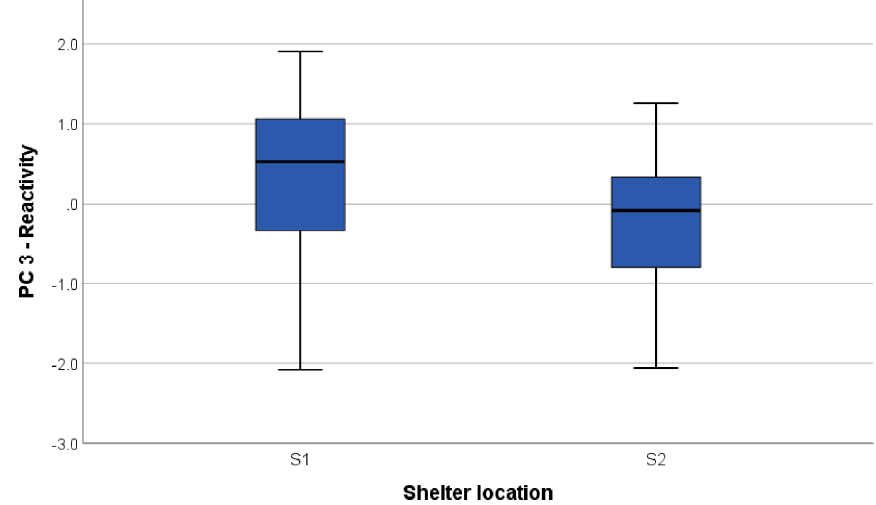
Figure 4. Boxplot showing the difference in the ‘reactivity’ scores (component 3 of the PCA) between the dogs housed in the two different shelters: site 1 (S1) and site 2 (S2). Note: higher scores refer to less reactive dogs and better problem solvers.